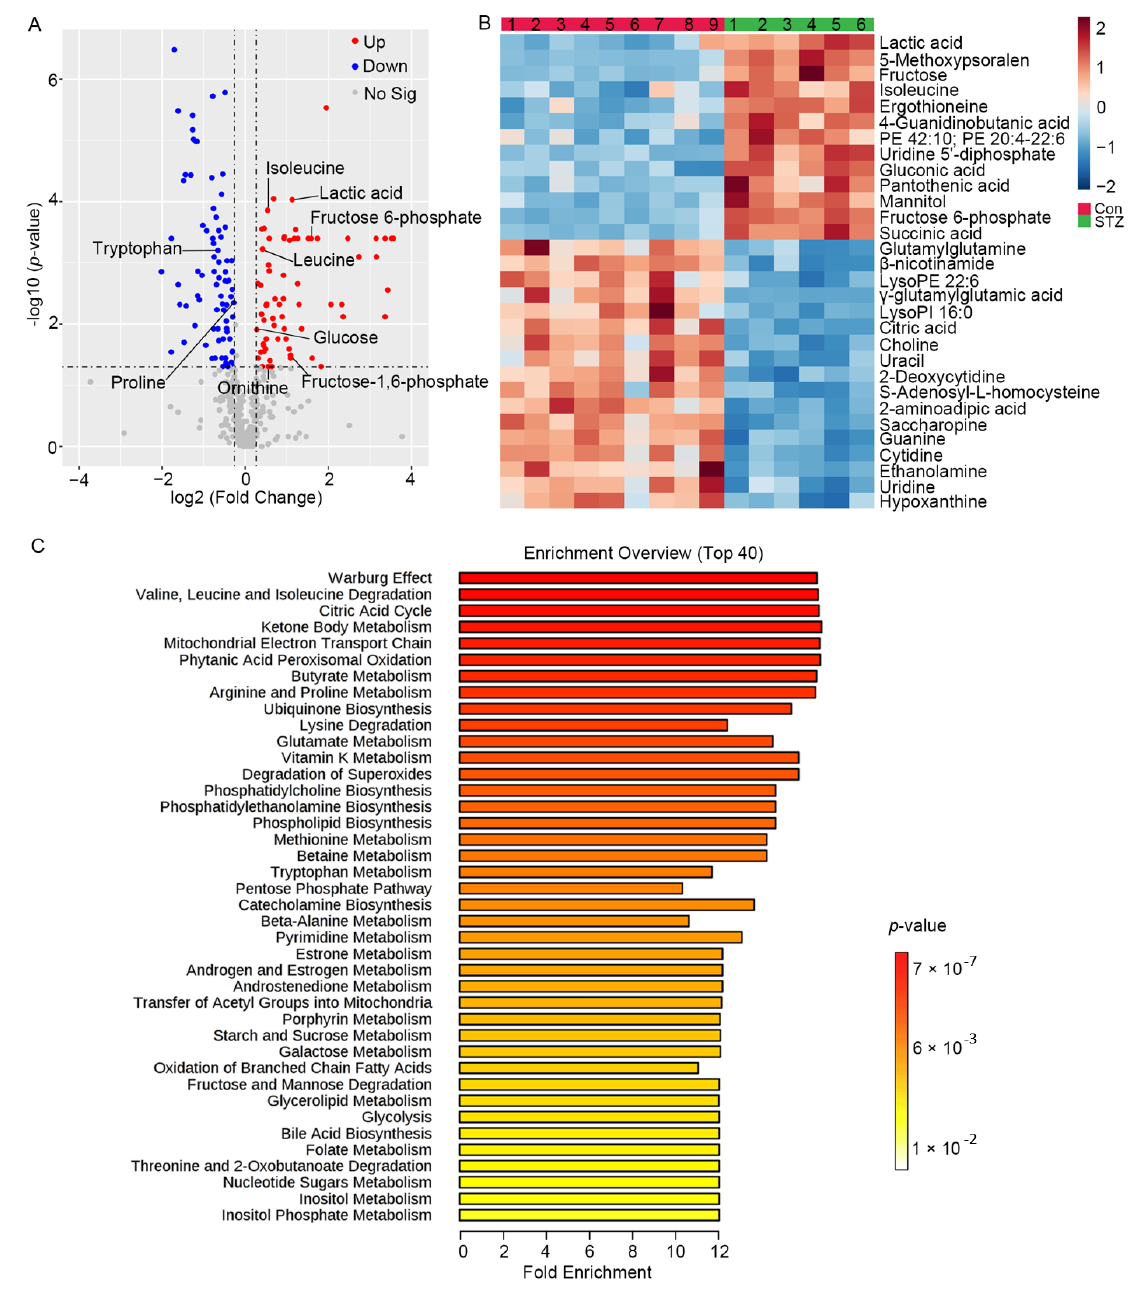
Figure 3. Metabolomics reveals differential metabolites and metabolic pathways in the diabetic retina of mice. ( A ) Volcano plot showing differential metabolites between two groups. Down-regulated and up-regulated metabolites are in blue and red, respectively. Non-significant metabolites are represented by gray dots ( p < 0.05, fold change >1.2 or <0.83). ( B ) Heatmap showing relative peak areas of top 30 dysregulated metabolites in retina; ( C ) Metabolite set enrichment analysis showed top 40 differential pathways differed between the STZ-induced diabetic group and control group ( p <